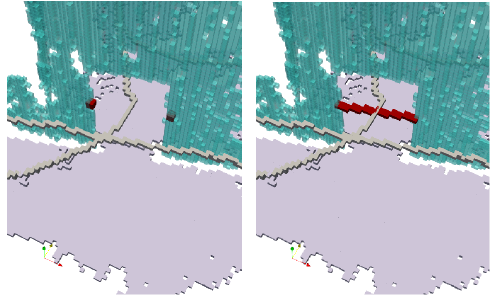
Figure 11. Left: Pair of MAT sheet voxels inside doorframe (red), right: voxel line drawn between pair of